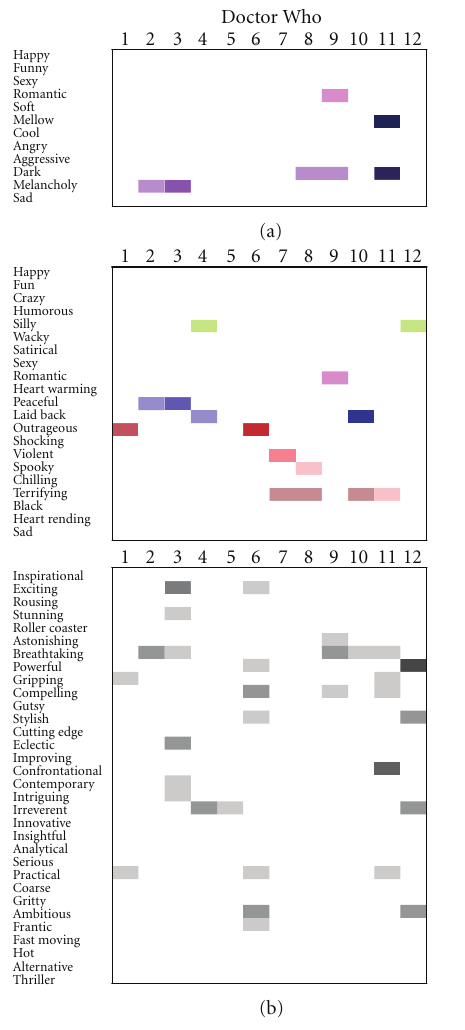
Figure 13: LSA correlation values of 12 episodes of (a) “Doctor Who” against last.fm tags, and (b) 53 tva atmosphere